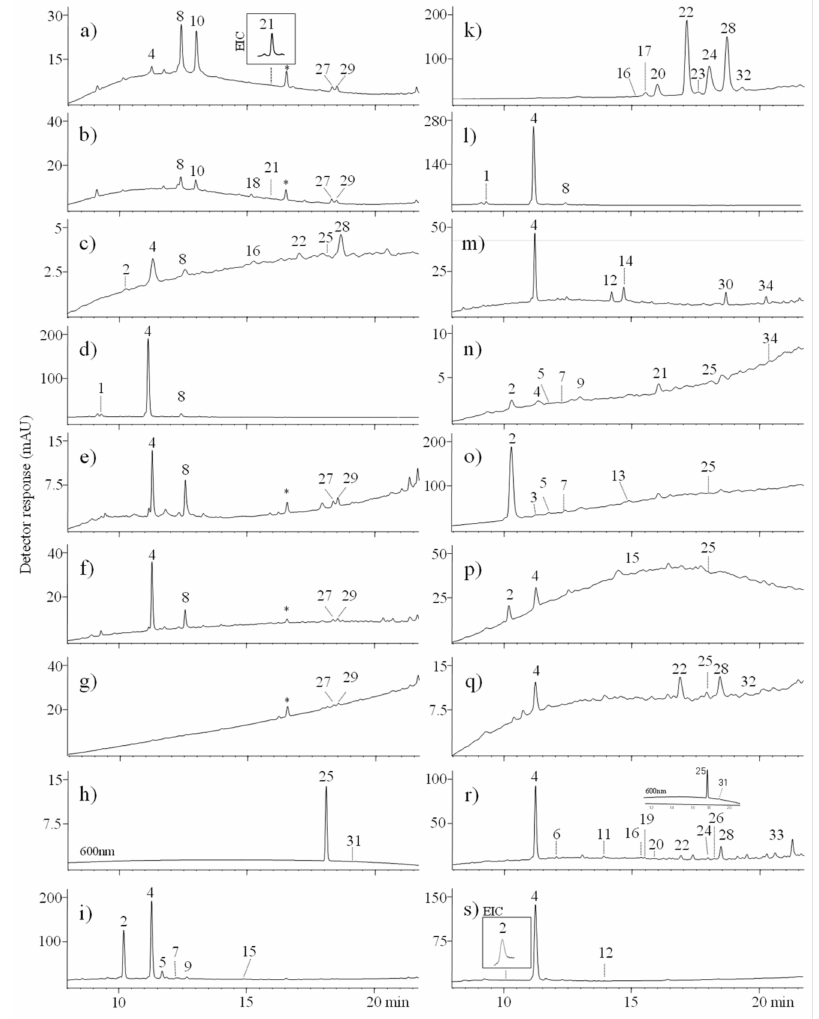
Figure 5. Spectrochromatograms of extracts taken from samples: ( a ) C2/b4-1, ( b ) C2/b4-2, ( c ) C3/b7, ( d ) C5/b9-1, ( e ) C5/b9-2, ( f ) C5/b11, ( g ) C5/b14, ( h ) C5/b25, ( i ) C5/b5-1, ( k ) C5/b5-2, ( l ) C6/b1, ( m ) C6/b2, ( n ) C7/b2, ( o ) C7/b4-1, ( p ) C7/b4-2, ( q ) C8/b6, ( r ) C8/b7, and ( s ) C9/b1-3. For chro- matographic conditions, see experimental section, * not ionised in ESI (+/ − ) mode. The burial textile C3/b7 contained indigotin, ellagic acid, red anthraquinones: